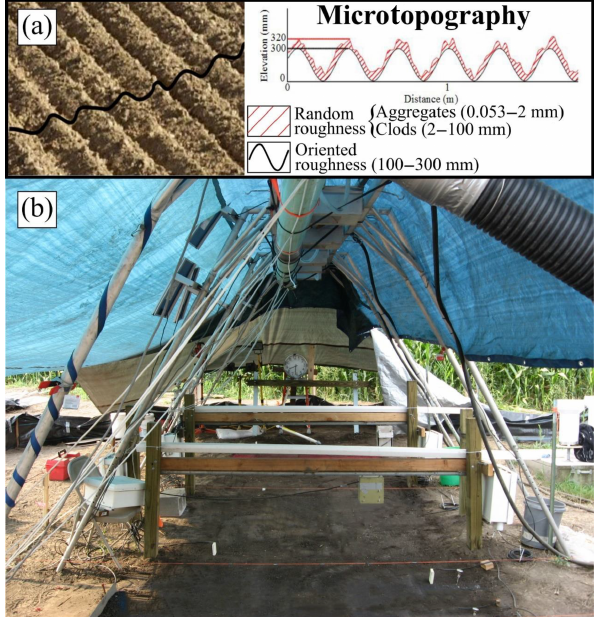
Figure 2. (a) Types of soil surface microroughness. (b) Experimen- tal plot. The rainfall simulator is placed above the bare soil surface and a base made of wood is put into place to facilitate the movement of the surface-profile laser scanner.